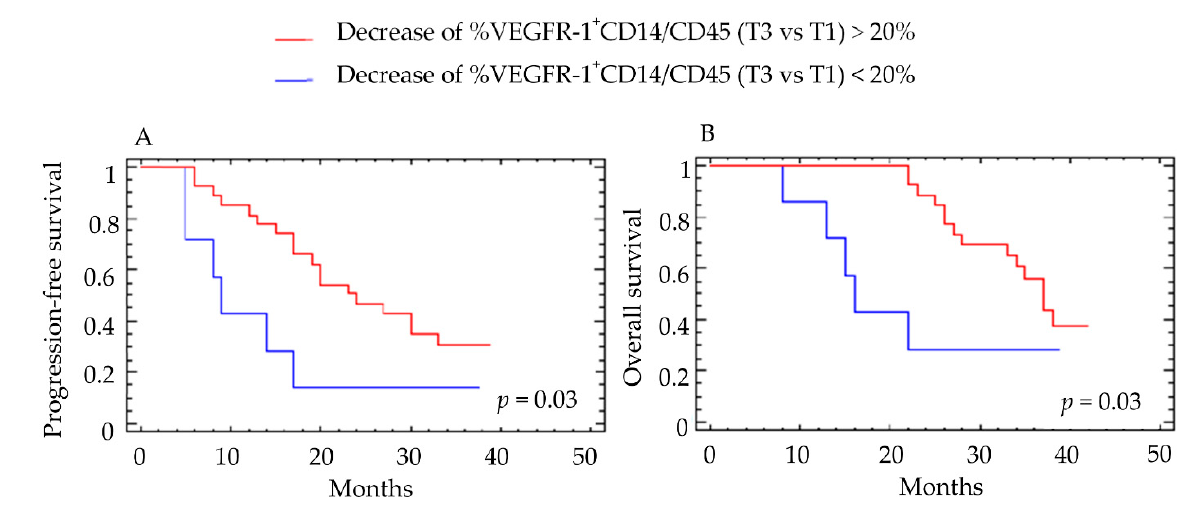
Figure 4. Correlation between the percent decrease in VEGFR-1 + CD14/CD45 + cells and clinical outcome. The percentage of VEGFR-1 + CD14/CD45 + cells was determined by cytometry before (T1) and at the end of anti-angiogenic therapy (T3). Patients were classified into two groups according to a cutoff value of 20% decrease in VEGFR-1 + CD14/CD45 + cells. Results for ( A ) progression-free survival (PFS) and ( B ) overall survival (OS) are presented. For PFS, the group with >20% decrease included 40 patients and the group with <20% decrease included 12 patients. For OS, the group with >20% decrease included 45 patients and the group with <20% decrease included 13 patients. Log-rank test was used for the statistical analysis.